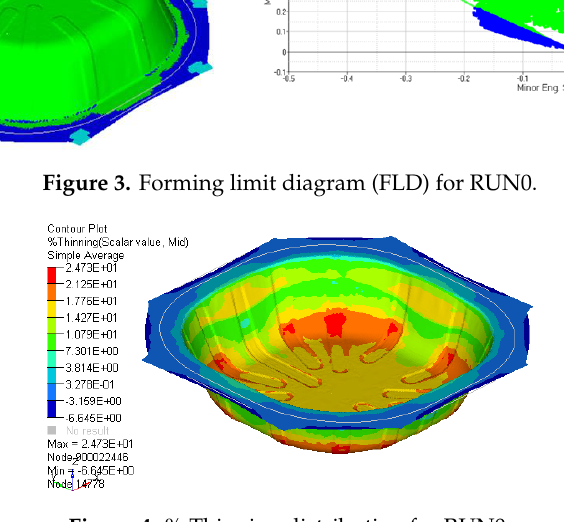
Figure 4. % Thinning distribution for RUN0.